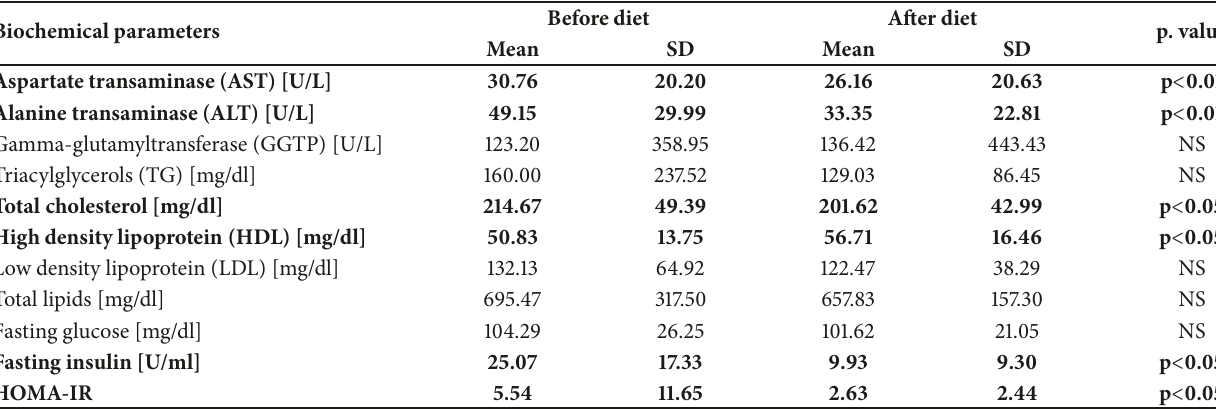
Table 3: The differences in biochemical parameters before and after the application of the diet. Biochemical parameters